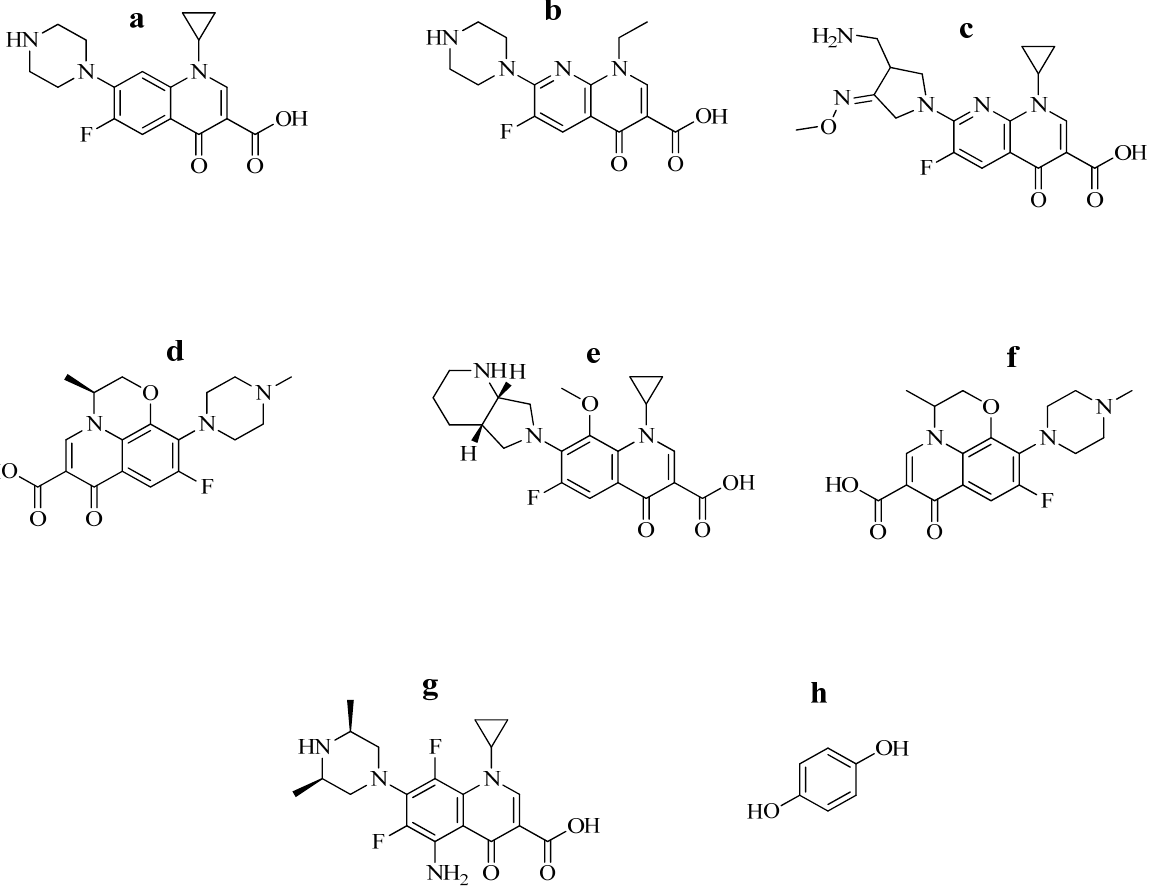
Figure 2. Study drugs ( a ) ciprofloxacin, ( b ) enoxacin sesquihydrate, ( c ) gemifloxacin, ( d ) levofloxacin, ( e ) moxifloxacin, ( f ) ofloxacin, ( g ) sparfloxacin and ( h ) hydroquinone. Their structures are adopted with permission [8,53].